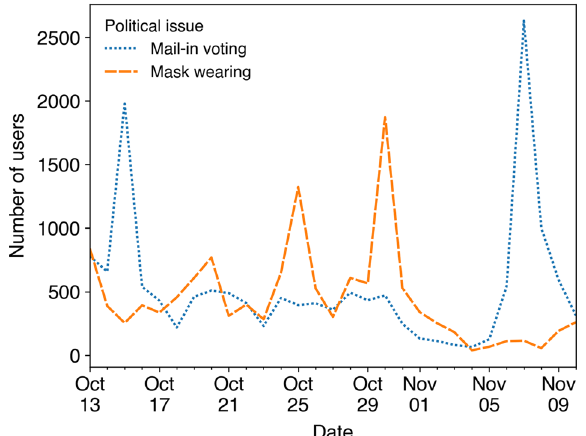
Fig. 1 The daily number of users mentioning partisan hashtags on mail-in voting or mask wearing in late 2020. These hashtags are listed in Additional file 2: